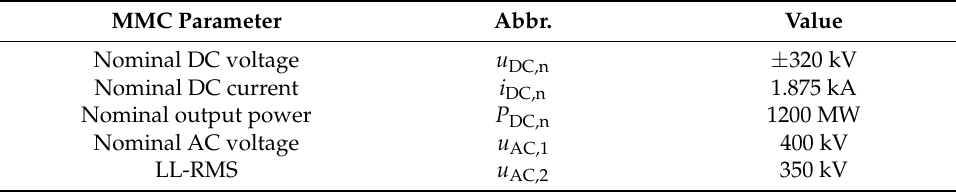
Figure 2. Schematic representation of an MMC. Table 1. MMC Parameters.